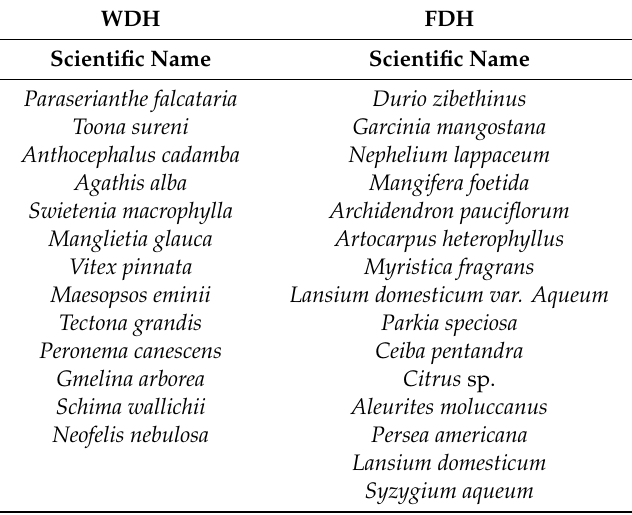
Table 4. List of tree species mainly distributed in woody-dominated home gardens (WDH) and fruit-dominated home gardens